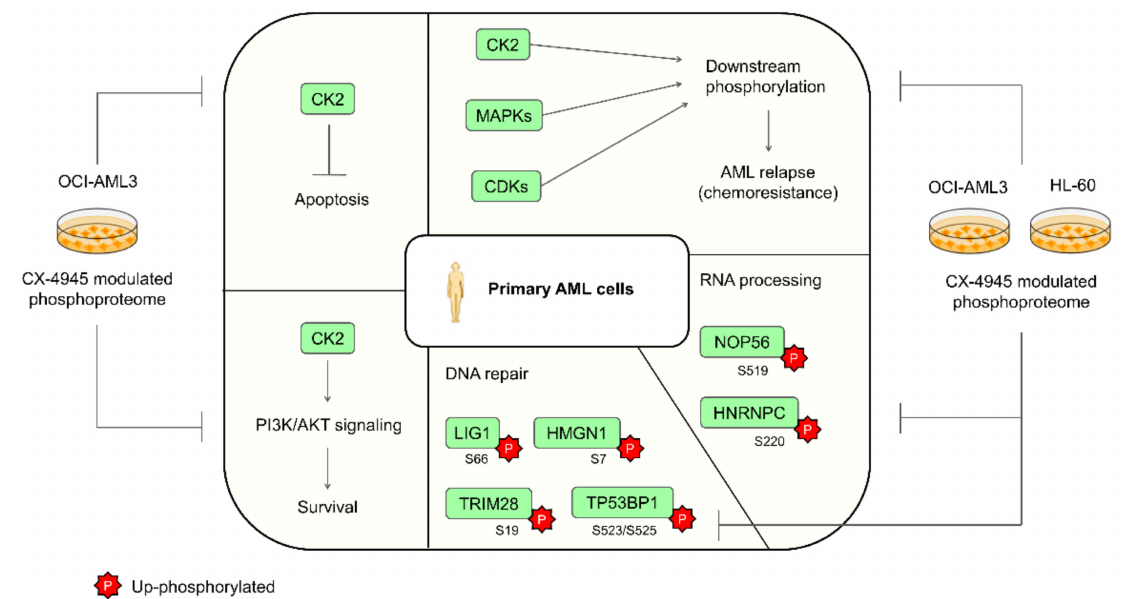
Figure 7. Signaling pathways and biological processes deregulated in primary AML cells and modulated by the CK2 inhibitor CX-4945 in AML cell lines. Phosphoproteins up-regulated in primary AML cells and down-phosphorylated in CX-4945-treated AML cells are